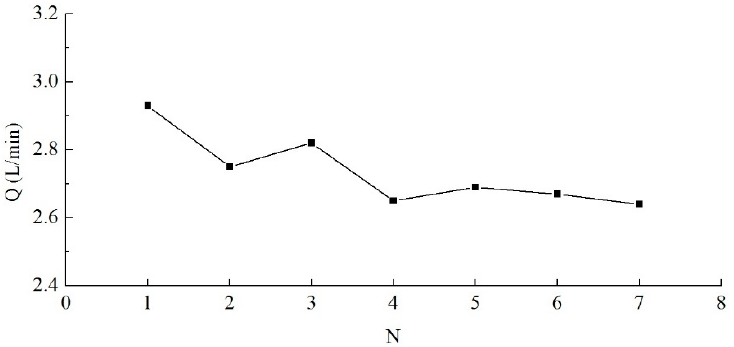
Figure 9. Curve between the single-well recharge quantity Q and the repeated recharge test time